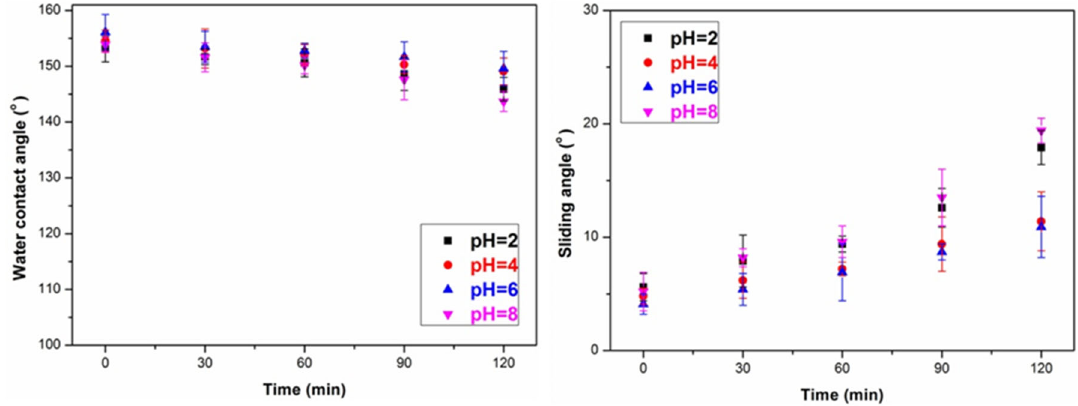
Figure 4. Variations in the WCA and SA in solutions with different pH